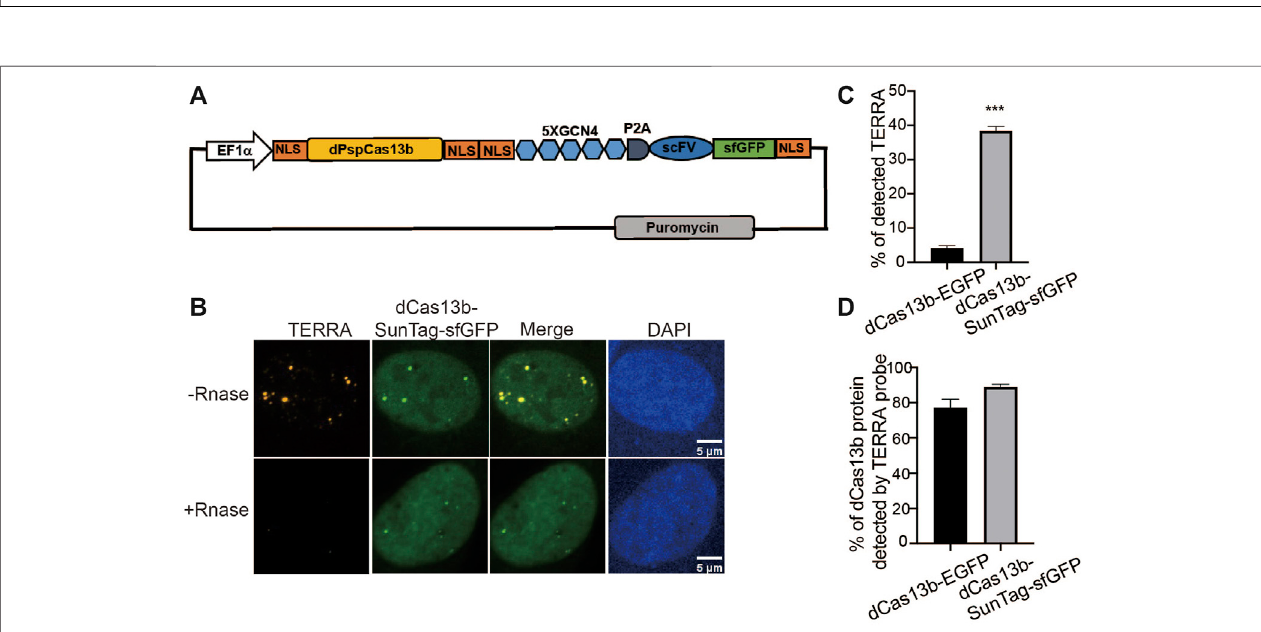
FIGURE 2 | SunTag increases TERRA labeling ef fi ciency. (A) Plasmid map of dCas13b tagged with SunTag, including fi ve repeats of GCN4, single-chain variable fragment antibody (scFV) followed by superfolded GFP (sfGFP). (B) TERRA RNA FISH shows co-localization of dCas13b-SunTag-sfGFP with TERRA FISH probe (orange). (C) Quanti fi cation forpercentage ofTERRA FISH foci labeled bydCas13b-EGFP and dCas13b-SunTag-sfGFP (mean ± SEM,unpaired t -test).N ≥ 80 foreach group. *** p < 0.001. (D) Quanti fi cation for percentage of dCas13b-EGFP and dCas13b-SunTag-sfGFP labeled by TERRA FISH (mean ± SEM). N ≥ 30 for each